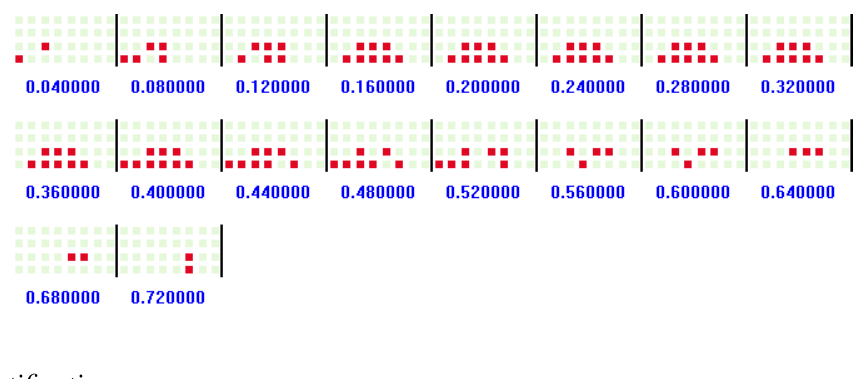
Figure 10. An array of sampled transitional